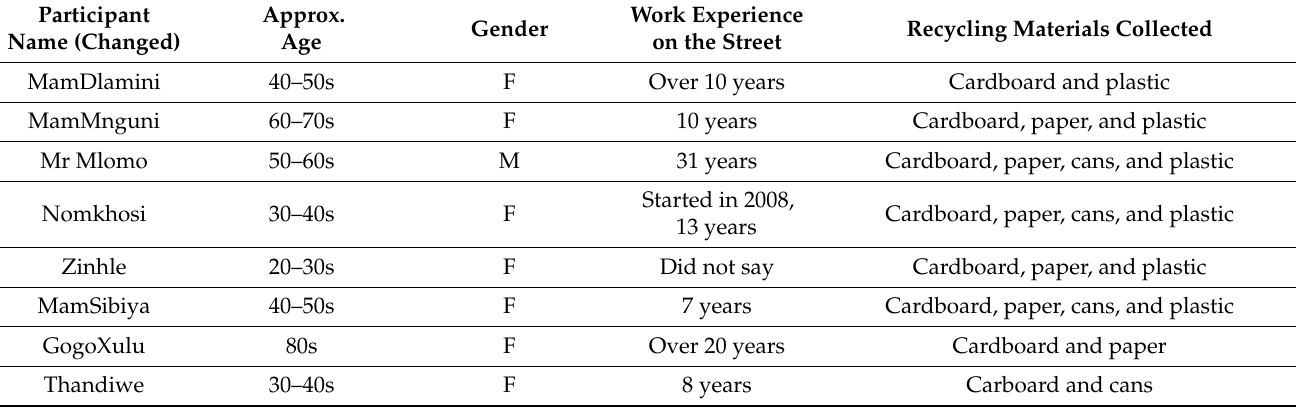
Table 1. Outline of research